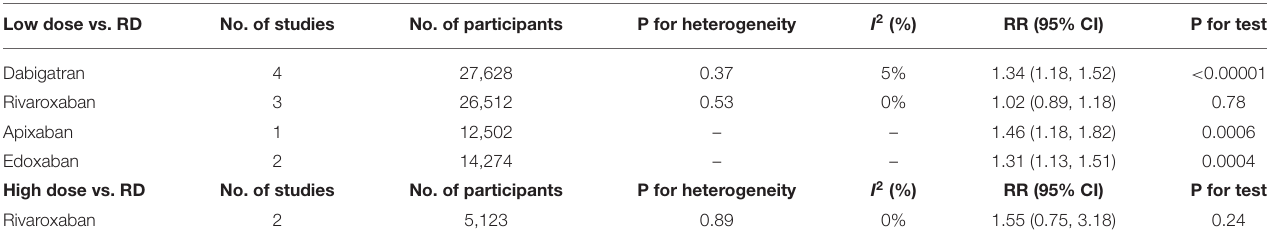
TABLE 6 | Stroke or systemic embolism of low/high dose of individual NOACs compared to recommended dose. Low dose vs.